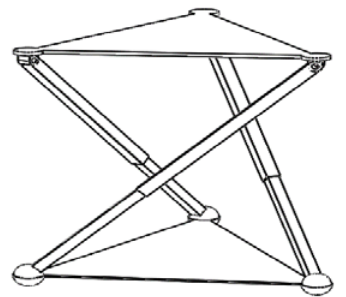
Figure 15. The second optimization structure.